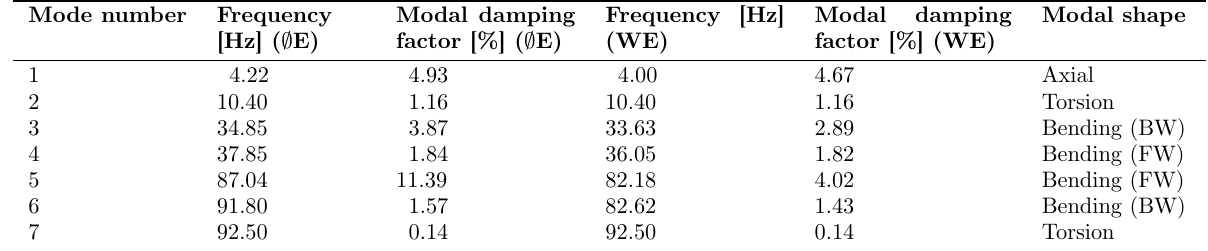
Fig. 4. Campbell diagram of the rotor test bench. Table 4. Seven first numerical modes of the rotor test bench at ˙ φ ∗ = 1700 rpm (FW: forward whirl, BW: backward whirl, WE: with encoders, ∅ E: without